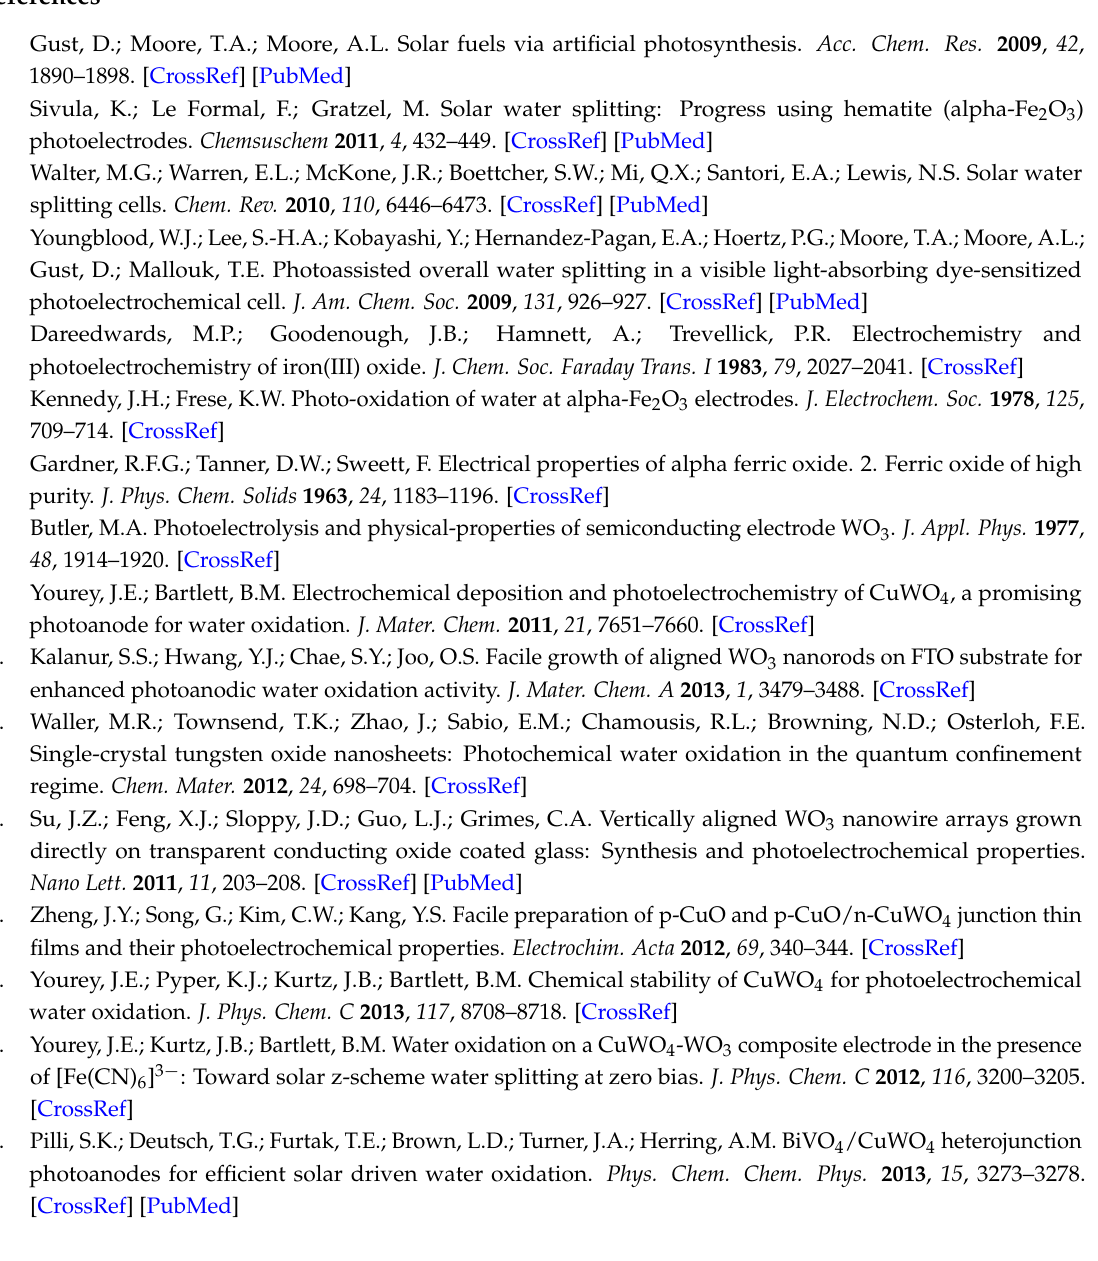
Figure S2: TEM images of particles scraped from WO 3 /CuWO 4 , indicating network morphology of the CuWO 4 layer. Figure S3: Photocurrent comparison of thin film obtained from different runs of dip coating. Figure S4: Mott-Schottky plots of WO 3 /CuWO 4 thin film at 10 k and 5 k Hz under dark conditions. Figure S5: Absorption efficiency of the WO 3 , CuWO 4 and WO 3 /CuWO 4 thin film by measuring the transmission and reflection spectra using an integrating sphere (Absorbance ( η abs ) = 1 ´ Transmittance ´ Reflectance). Figure S6: Linear sweep voltammetry of all samples with (solid lines) and without the illumination of AM 1.5 (dashed lines), measured in 0.5 M Na 2 SO 4 + 0.5 M H 2 O 2 aqueous